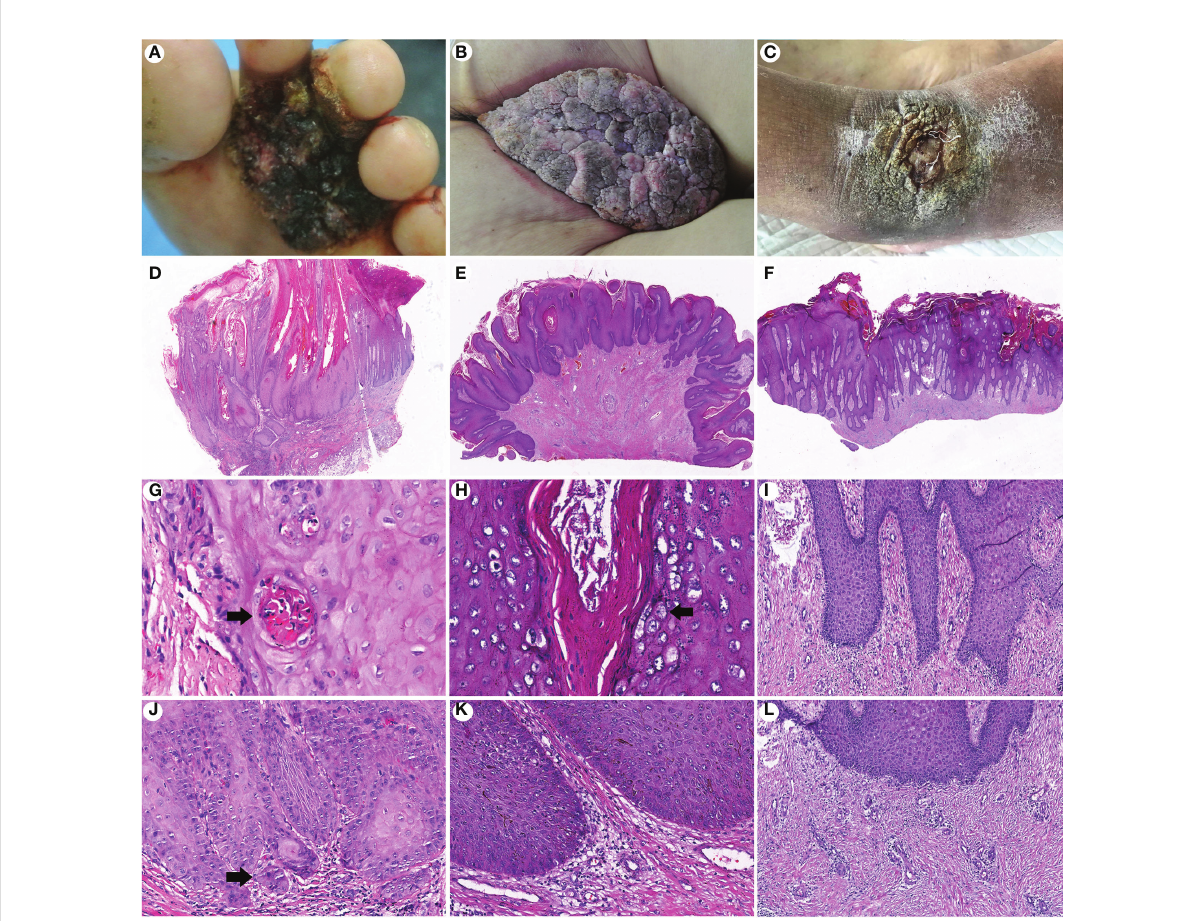
FIGURE 3 Comparison of clinicopathological features of cutaneous verrucous carcinoma (A, D, G, J) , giant condyloma acuminatum (B, E, H, K) , and pseudoepitheliomatous hyperplasia (C, F, I, L) . (A) A verrucous mass in the forefoot. (B) A large cauli fl ower-like mass in the perianal area. (C) A verrucous plaque in the right dorsal foot. (D) An exo-endophytic growth pattern with pushing margins (H&E, ×10). (E) An exophytic growth pattern (H&E, ×10). (F) An endophytic growth pattern (H&E, ×10). (G) Well-differentiated keratinocytes with severe keratinization and intraepithelial microabscesses (arrow) (H&E, ×400). (H) Koilocytotic cells in the granular layer (arrow) (H&E, ×400). (I) More basophilic and irregular acanthosis (H&E, ×200). (J) Basal cell atypia with microinvasion (arrow) (H&E, ×200). (K) Mild dermal in fl ammation in fi ltration without basal cell atypia (H&E, ×200). (L) Perivascular lymphocytic in fi ltration (H&E,